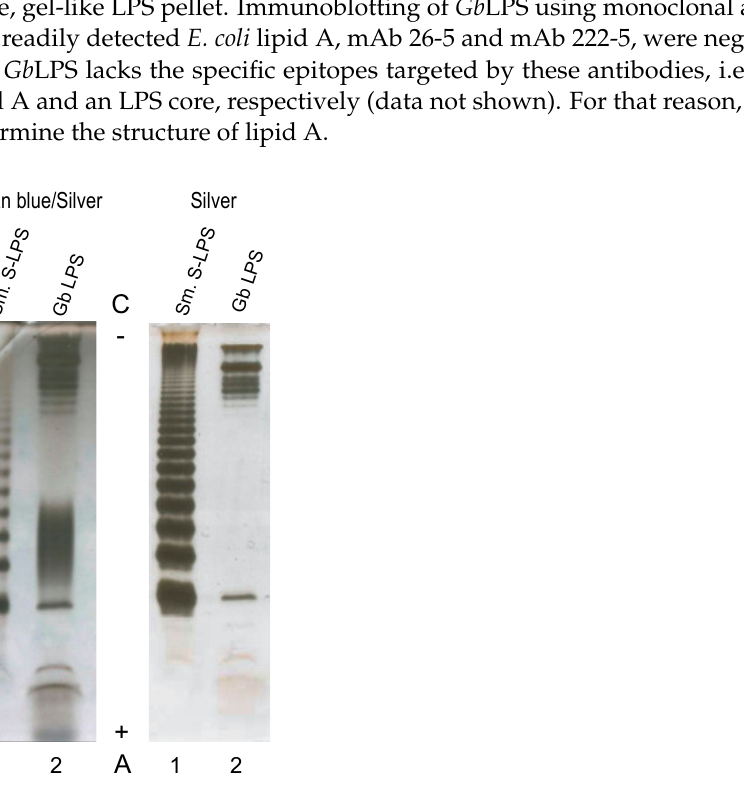
Figure 2. Deoxycholic acid (DOC)-PAGE analysis of a lipopolysaccharide (LPS) isolated from G. bethesdensis . Samples were stained with Alcian blue, followed by silver staining, or only with silver. (Lane 1) Salmonella enterica sv. Minnesota, S-type LPS (Sm. S-LPS) (1 µg). (Lane 2) G. bethesdensis LPS (Gb LPS) (1µg). (A+) anode and (C-) cathode regions of the PAGE gel.